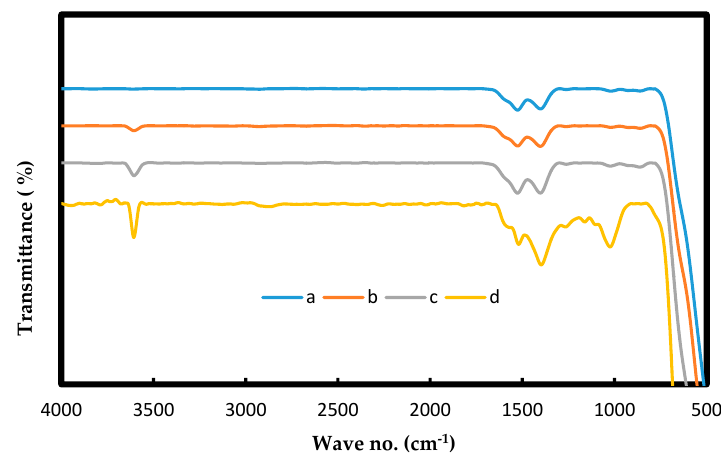
Figure 2. FT-IR spectra of the catalysts: ( a ) Pt,Pd,Ni / MgO, ( b ) Pd,Pd,Ni / Mg 0.97 La 3 + 0.03 O, ( c ) Pd,Pd,Ni / Mg 0.93 La 3 + 0.07 O, ( d ) Pd,Pd,Ni / Mg 0.85 La 3 + 0.15